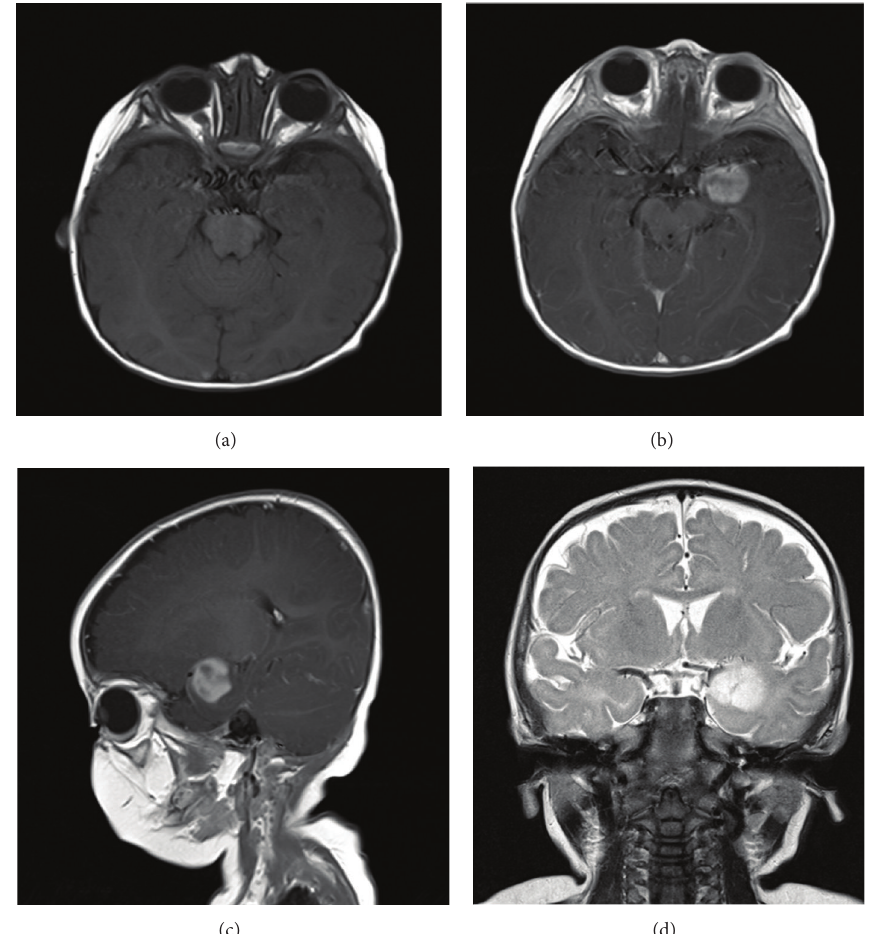
Figure 1: (a) Axial T1 precontrast, (b) axial T1 postcontrast, (c) sagittal T1 postcontrast, and (d) coronal T2 magnetic resonance imaging show a heterogeneously enhancing mass in the left temporal